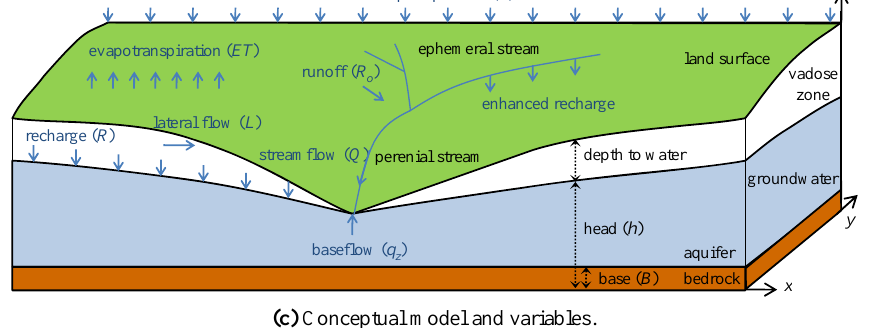
(a) Perennial streams in the lowland prairie, with the Kansas River valley in the far distance to the left.